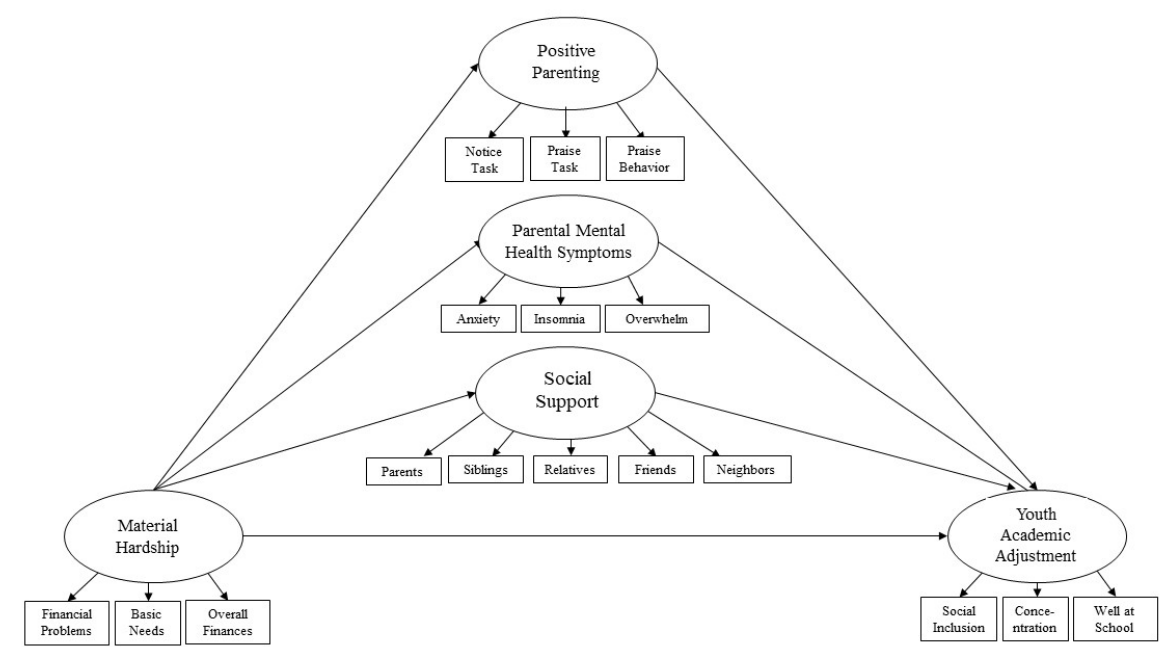
Figure 1. Conceptual Model.